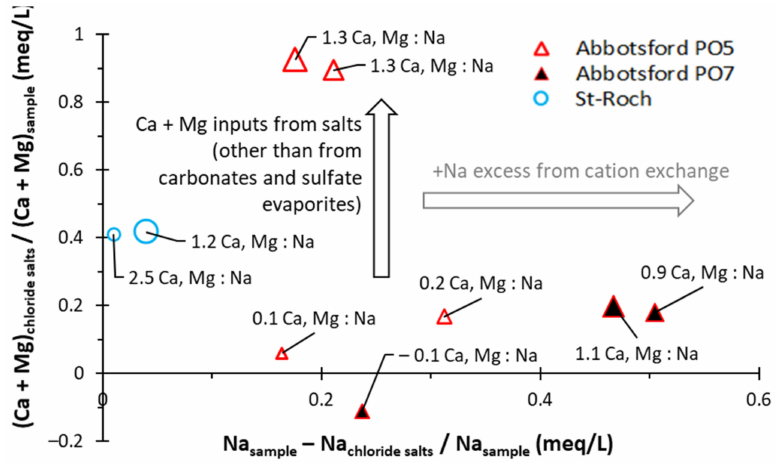
Figure 12. Ratio of Ca 2+ , Mg 2+ and Na + contributions from chloride salts evaluated in the samples showing an anionic composition dominated by Cl − (St. Roch and Abbotsford wellbores).